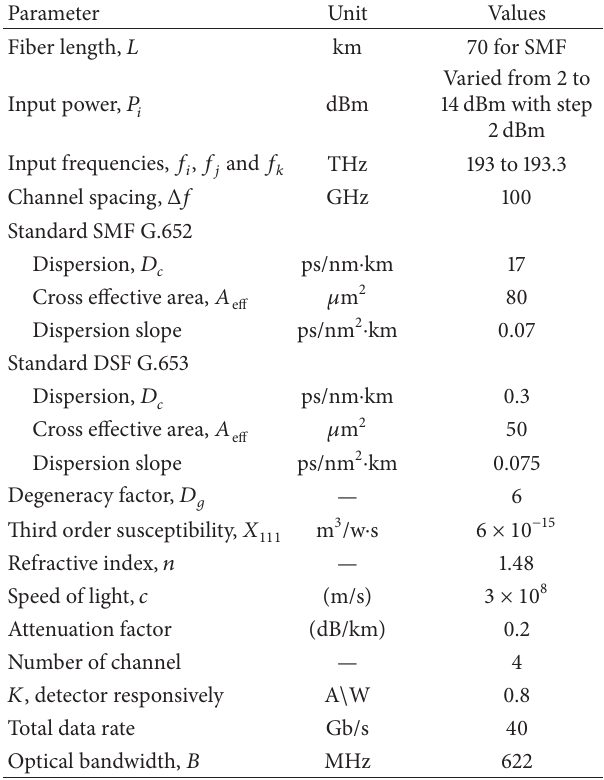
Table 1: System simulation